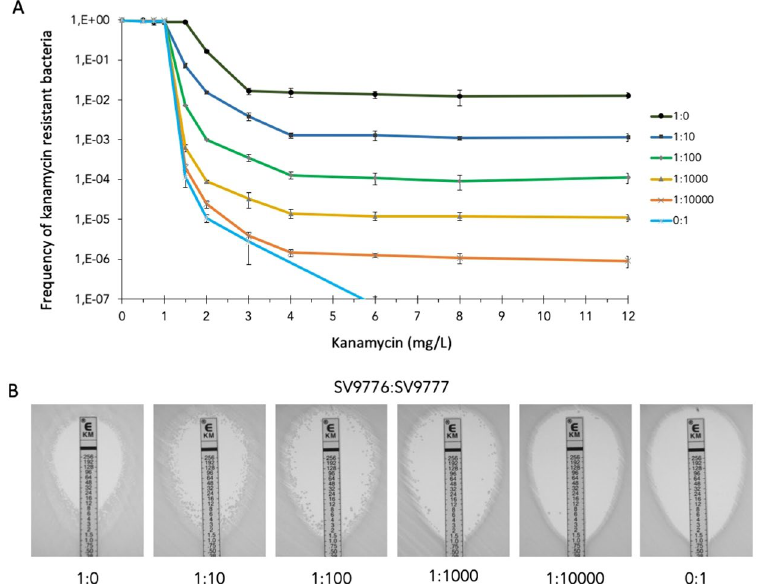
Figure 4. The opvAB switch as a tool for the study of antibiotic heteroresistance. ( A ) Population analysis profile (PAP) tests of kanamycin resistance in strains SV9776 and SV9777 (carrying P opvAB ::BI- aac3 :: gfp and P opvAB :: gfp constructs, respectively). The proportions indicated are those of the mixtures of SV9776:SV9777. Error bars represent standard deviations of three independent mixtures. ( B ) Epsilometer tests (Etests) performed on the same mixtures of SV9776 and SV9777. The kanamycin resistant subpopulations appear as low-density lawns (mixtures 1:0 and 1:10) or as isolated colonies growing at kanamycin concentrations above the MIC of the main susceptible population ([Km] > 1 mg/L - mixtures 1:10 to 1:10,000). No kanamycin resistant subpopulation exists for the 0:1